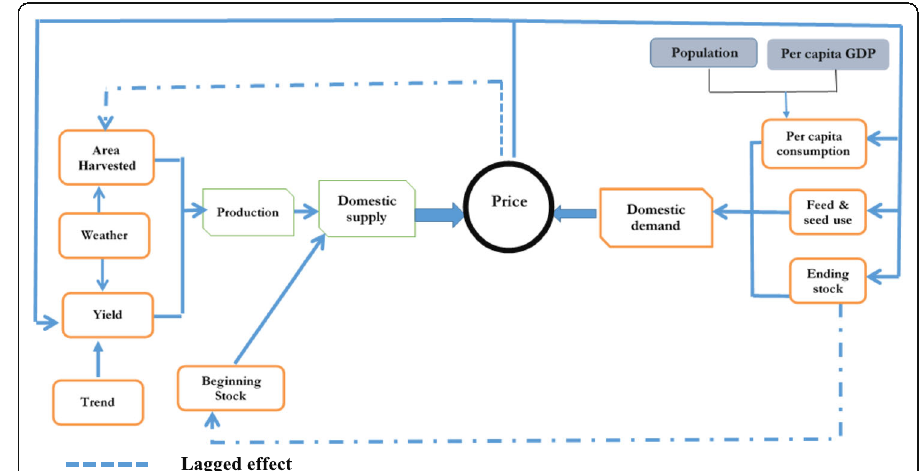
Fig. 2 White maize price formation in Ethiopia under autarky trade regime. Source: Adapted from Meyer et al.